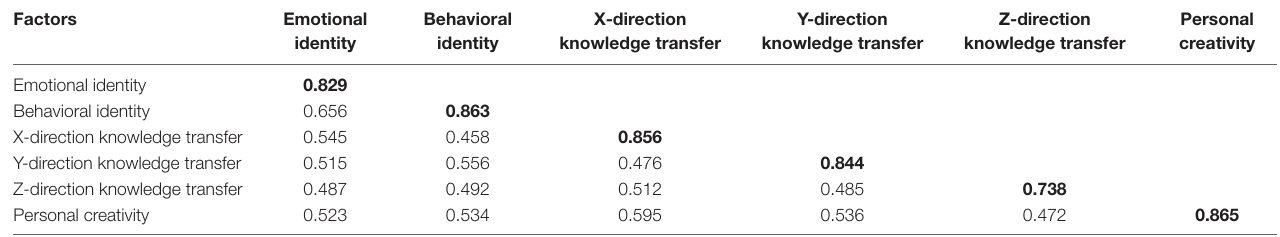
TABLE 5 | Factor correlation coefficient matrix.